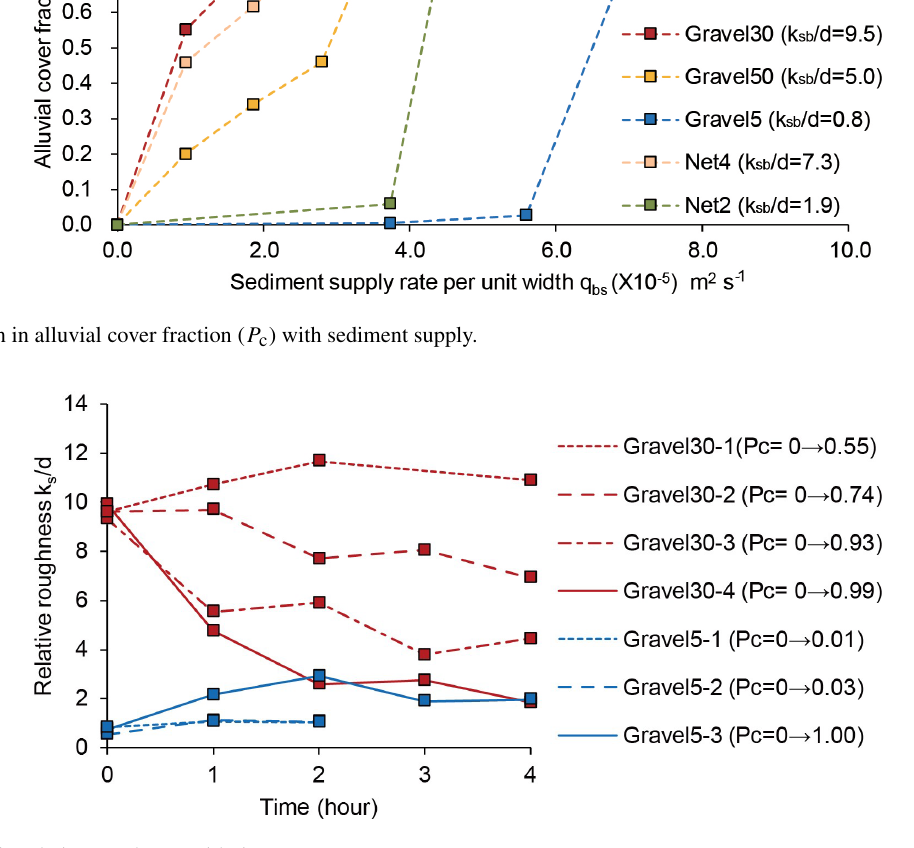
4 Discussion and comparison of the